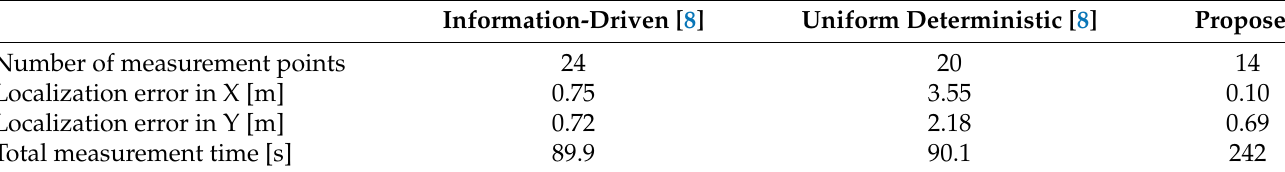
Figure 16. Simulation results in large area: the red dot is the radiation source, and the black line depicts the determined path. It is confirmed that the robot accurately estimated the direction of existing the source despite of the large area. The robot approached to the source and measured gamma rays while circumnavigating the source. Table 1. Performance